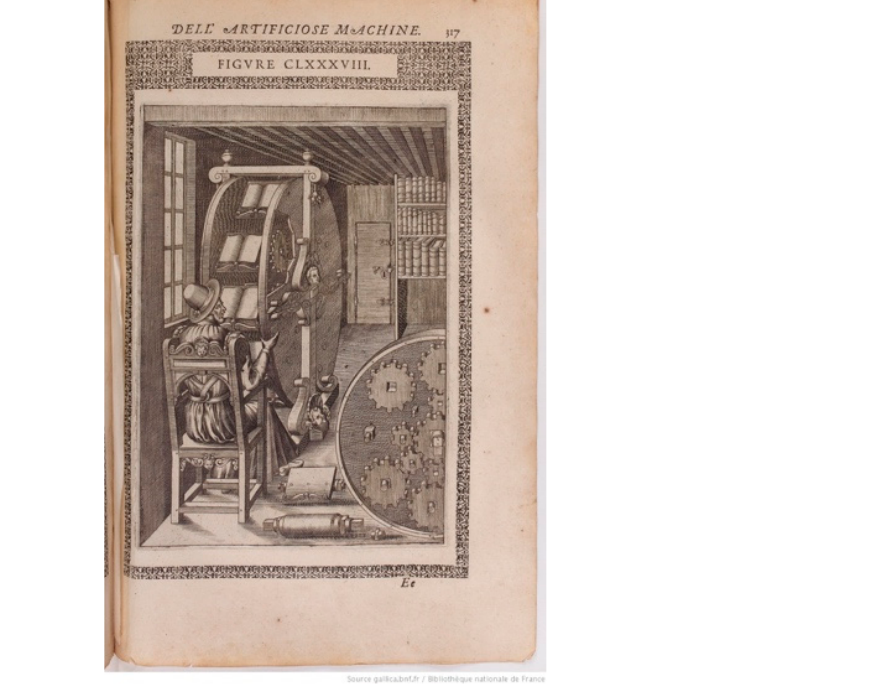
Figure 2. Agostino Ramelli, Delle artificiose Machine, 1588, p. 317. Image in CC0-Creative Commons. A rotating system allowed multiple items to be read at the same time. The solution could therefore be a system similar to a rotating conveyer belt, capable of digitizing the same item simultaneously in recto/verso (Figure 3). A further requirement was sustainability and autonomy in customizing the device. It was necessary to produce a modular scanner whose constituent elements could be replaced by choosing better ones, corresponding to evolving performances, and which were made up of interchangeable parts available on the market without having to go through specific production companies. Last aspect: the possibility of associating the scanner with scanning software produced for the occasion and specific to our collection indexing